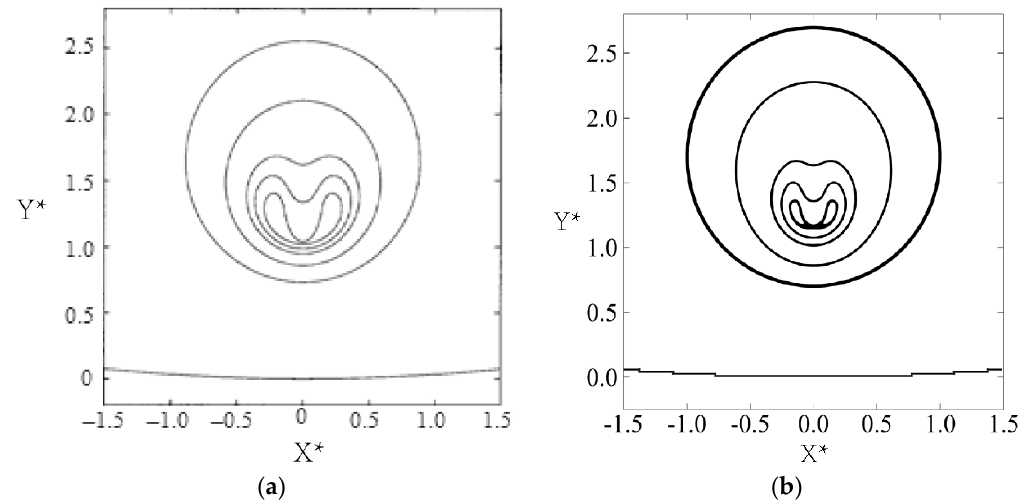
Figure 3. Comparison of the results between Boundary integral method (BIM) [9] and LBM-MRT. ( a ) BIM results, ( b ) LBM results.